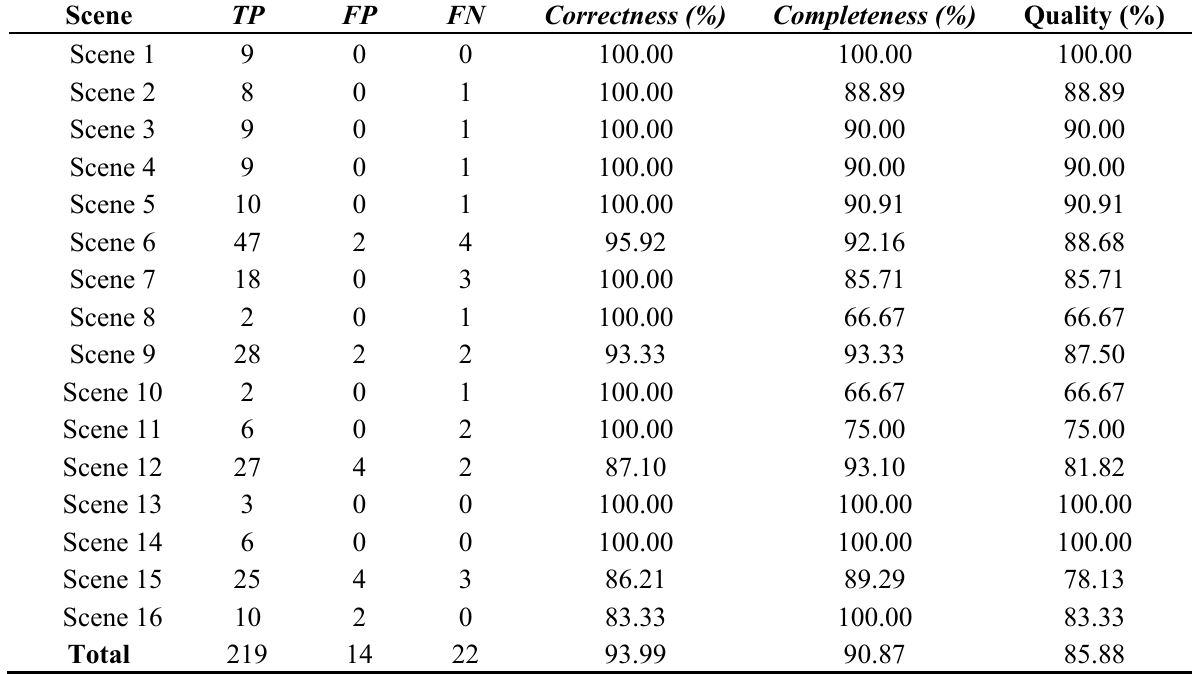
Table 1. Moving vehicle detection results of sixteen scenes. TP, true positive; FP, false positive; FN, false